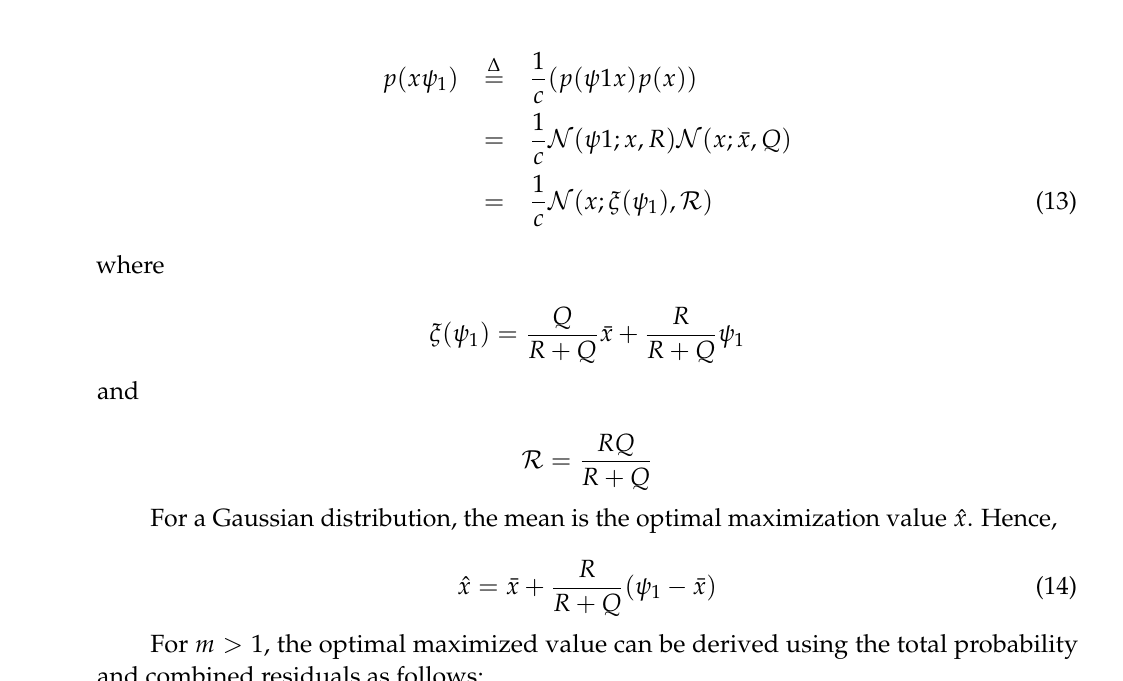
Algorithm 1 handles each partition separately, but by extending the line